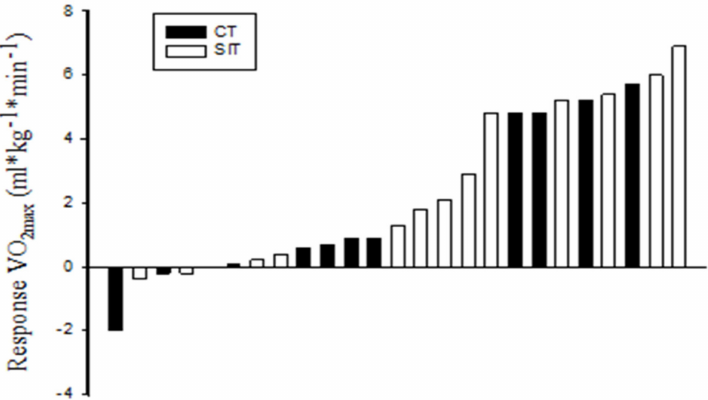
Figure 1. Individual change in maximal oxygen consumption (VO 2max ) after eight weeks of either continuous training (CT) or sprint interval training (SIT) (one subject in CT did not experience any